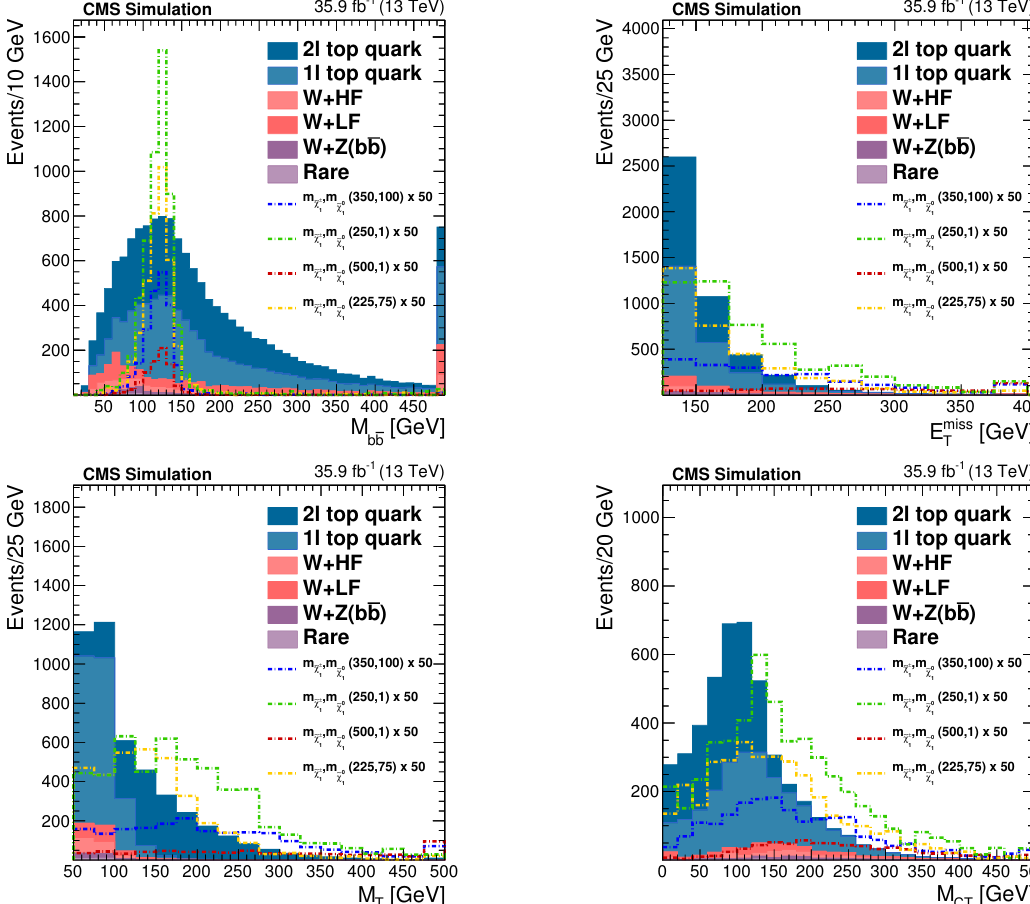
Figure 2 . Distributions in M right) for signal and background events in simulation after the preselection. The E miss M CT distributions are shown after the 90 < M